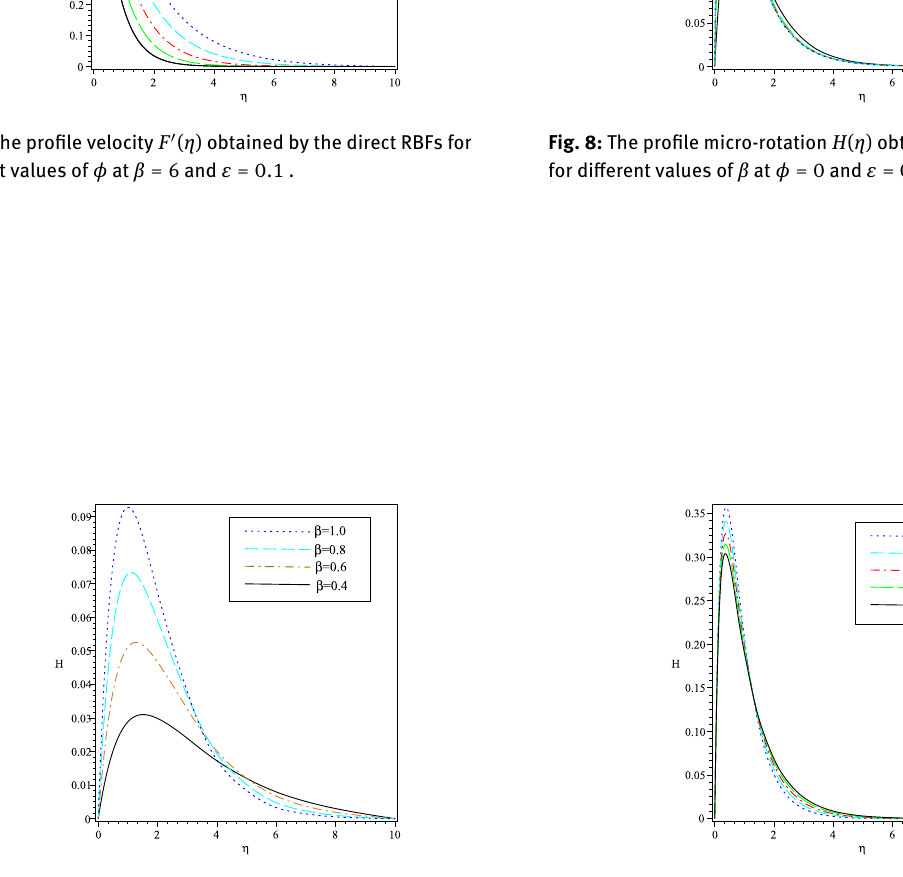
Fig. 9: The profile micro-rotation H ( η ) obtained by the indirect RBFs for different values of ε at β = 6 and ϕ = 0